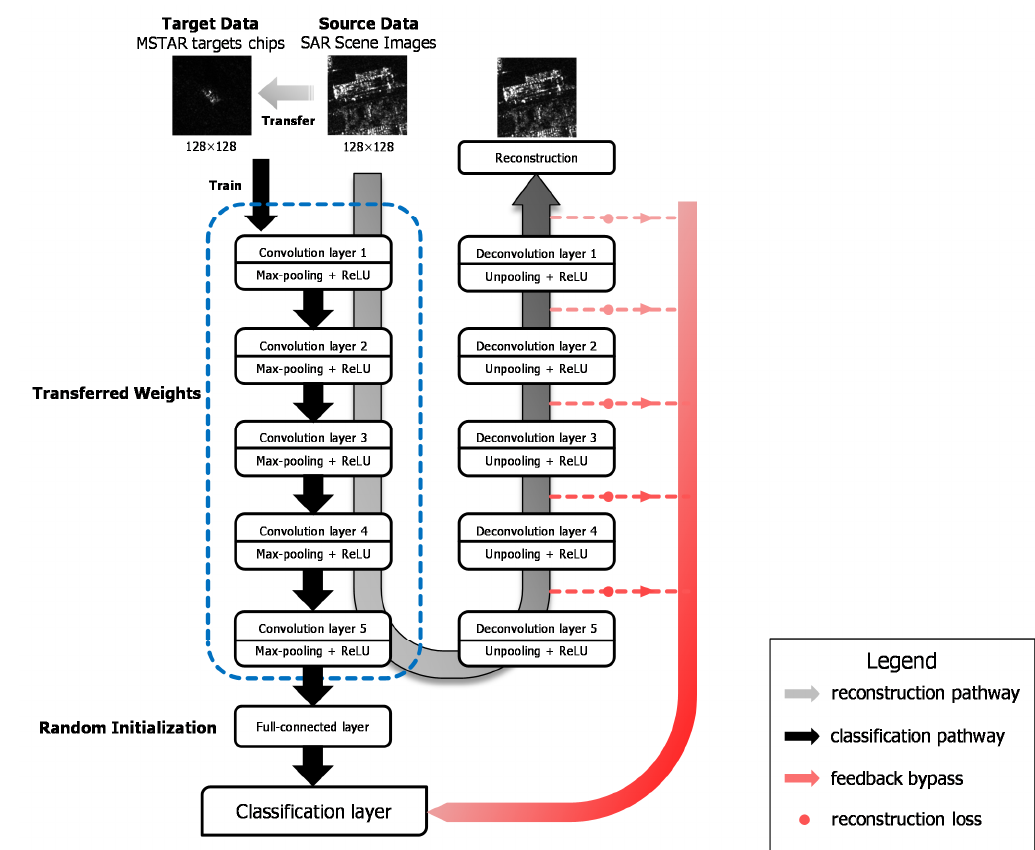
Figure 1. Assembled CNN